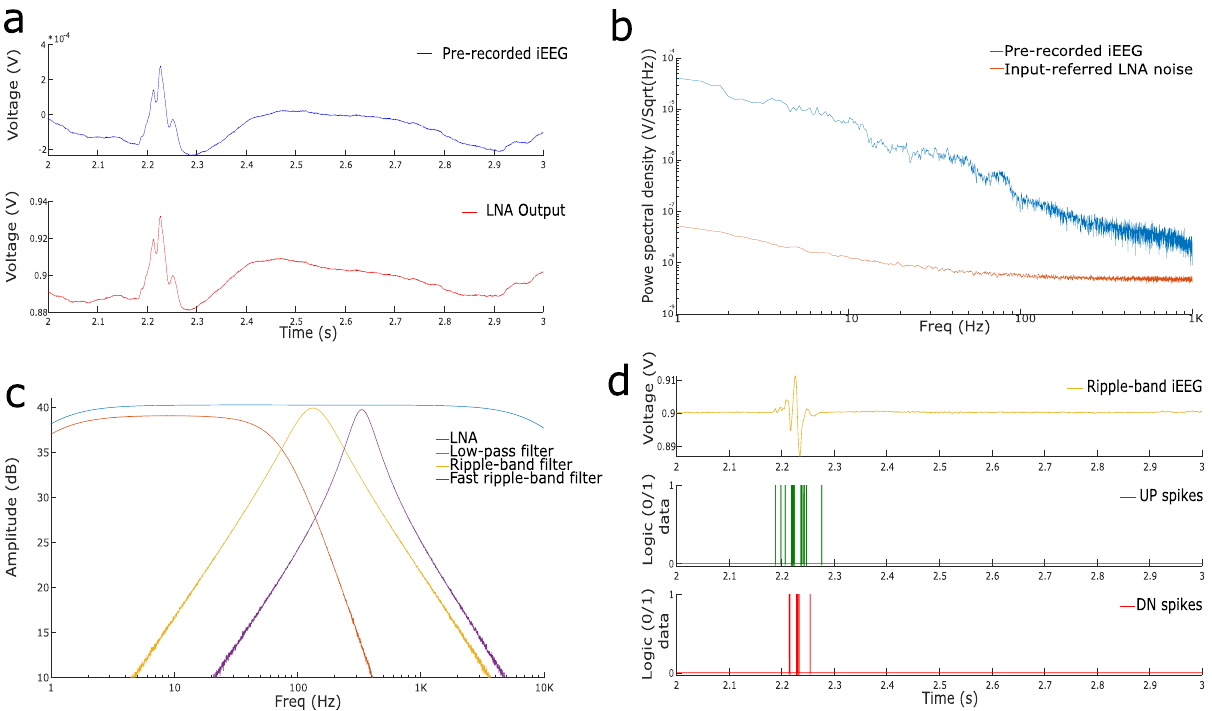
Fig. 4 Measurements from the analog headstage. a An iEEG sample 43 and the LNA ampli fi ed output. b Noise fl oor of the headstage LNA and iEEG power spectral density. In the HFO range (80-250 Hz) the noise level of the LNA is below the iEEG noise fl oor by an order of magnitude. c Frequency response of the implemented fi lters in the headstage. The band-pass fi lters are tuned to highlight HFO frequency bands. d ADM circuit simulation response to the ripple- fi ltered signal. The top plot shows the analog fi lter output, the middle plot shows the UP spikes generated by the ADM and the bottom plot shows the DN Figure 4d plots the spikes produced by the AMD circuit in response to Ripple-band data obtained from the pre-recorded iEEG measurements. We set the ADM refractory period to 300 μ s, making it the longest delay, compared to those introduced by the comparator and handshaking circuits, that are typically < 100 μ s. The spike-rate of the ADM can range from few hundreds of Hz to hundreds of kHz depending on the values of V tu , V td , and V refr . Each ADM consumed 1.5 nJ of energy per spike, and had a static power dissipation of 96 nW.